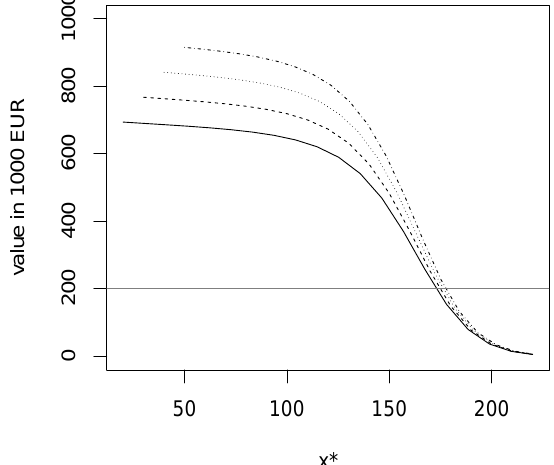
Figure 4. Lifetime value (cid:98) V ( x ∗ ) as a function of x ∗ with the Ornstein-Uhlenbeck model fitted in Section 4, with interest rate 3% per annum. Dashed line: p c + K c = 20, solid: p c + K c = 30, dotted: p c + K c = 40, mixed: p c + K c = 50. The horizontal grey line indicates the current price of lithium-ion battery storage per MWh (IRENA 2017, Figure